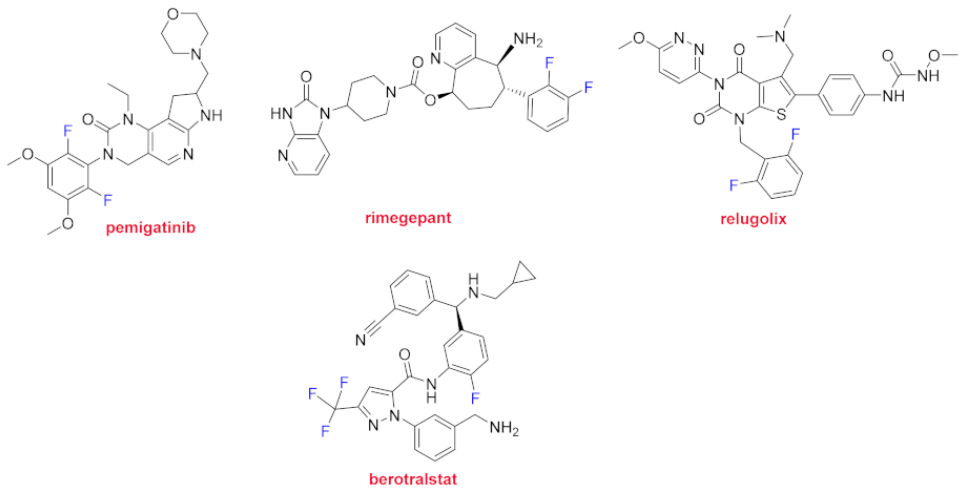
Figure 12. Structure of drugs containing more than one fluorine (fluorine atoms shown in blue). In addition to the 16 drugs that contain nitrogen aromatic heterocycles previously discussed, FDA authorization has been given to another 12 drugs with the same character- istics (Figures 13 and 14). This means that approximately 50% (28 out of 53) of the drugs approved this year belong to that class. If biologics and peptides are not considered, three out of every four drugs approved in 2020 (28 out of 37) contain nitrogen aromatic hete- rocycles. Two of these structures without fluorine atoms contain an oxadiazole ring. The immunomodulatory drug Ozanimod (Zeposia TM ) is the only FDA-approved sphingosine- 1-phosphate (S1P) receptor modulator indicated for the treatment of relapsing forms of multiple sclerosis (RMS). When administered together with levodopa (L-DOPA), opicapone (Ongentys TM ) restores the levels of dopamine in the regions of the brain that control move- ment and coordination. Two more drugs contain a pyrimidinone moiety. Risdiplam (Evrysdi TM ) is the first oral drug approved for the treatment of spinal muscular atrophy (SMA). Risdiplam also contains a pyridazine that modifies the splicing of a messenger RNA, thereby increasing the concentration of the functional survival motor neuron (SMN) protein in vivo. Vibegron (Gemtesa TM ), which is a β 3 -adrenergic receptor (AR) agonist, is recommended for the treatment of overactive bladder. Remimazolam (Byfavo TM ) is a benzodiazepine derivative used for the induction and maintenance of sedation. Tucatinib (Tukysa TM ) is an inhibitor of HER2 used for the treatment of HER2-positive breast cancer. Selpercatinib (Retevmo TM ) is the third drug approved this year for NSCLC and other RED fusion-positive thyroid